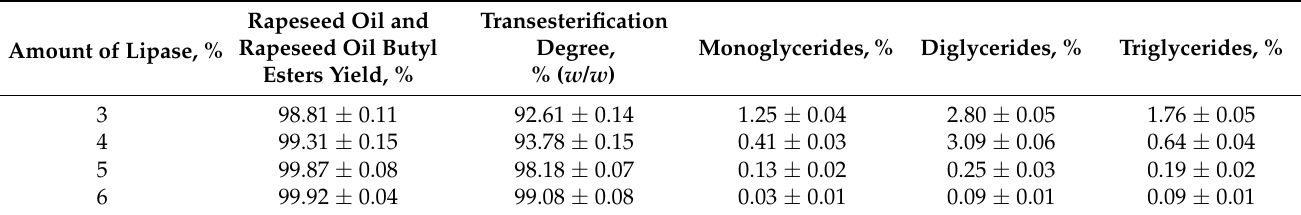
Table 4. Dependence of the yield of rapeseed oil, rapeseed oil butyl esters, the transesterification degree, and the glyceride content in reaction product on the lipase